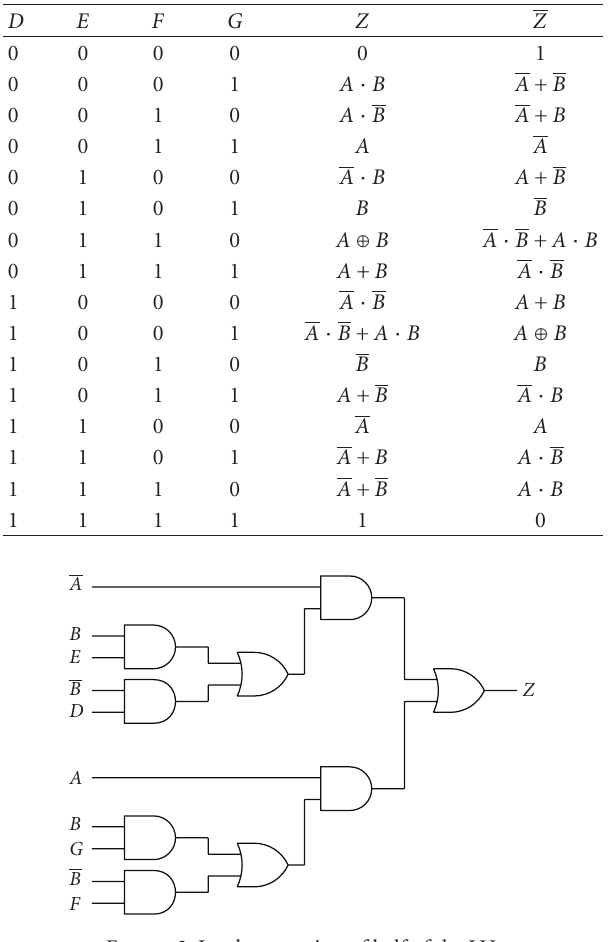
Figure 3: Implementation of half of the LU.